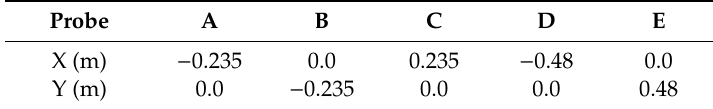
Table 1. Location of probes in the simulation